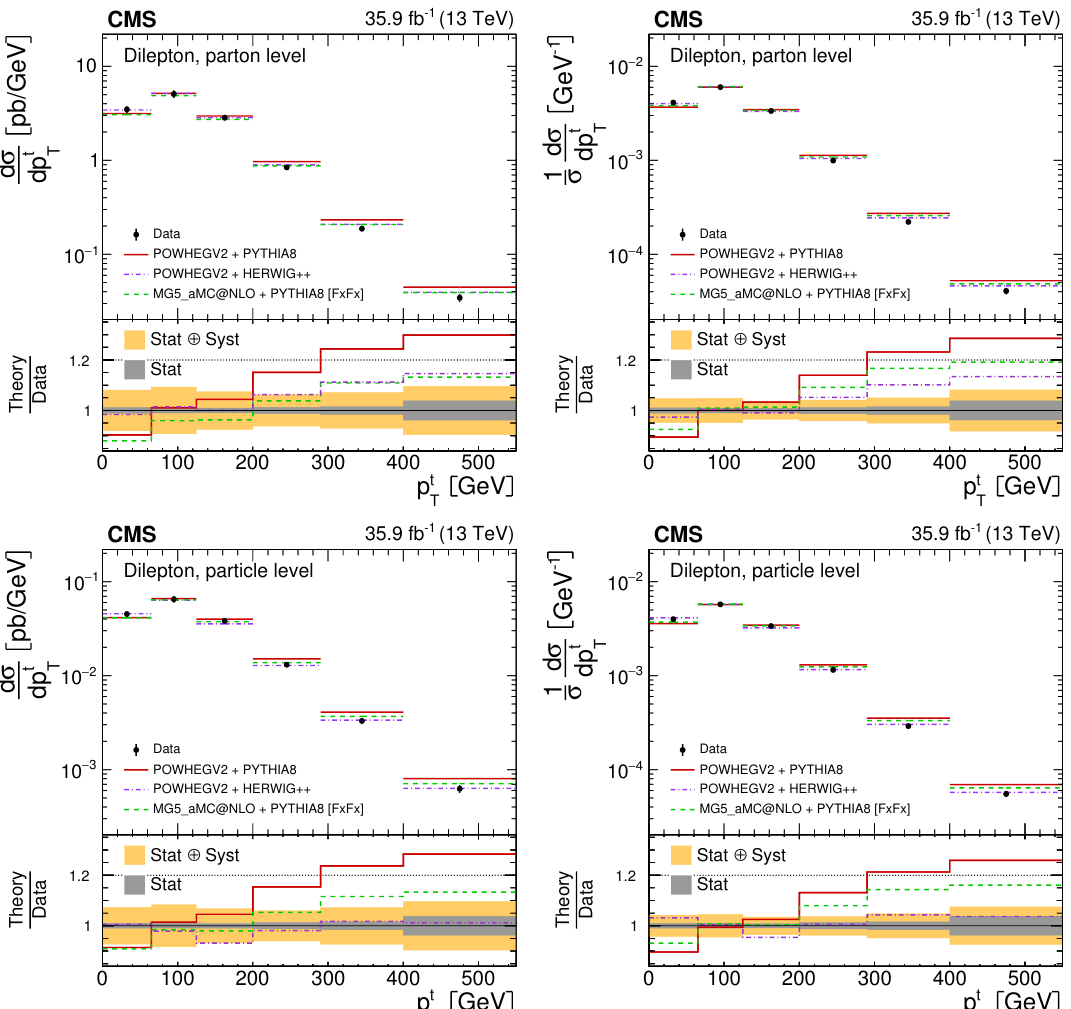
Figure 3 . The di(cid:11)erential tt production cross sections as a function of p t data (points) and the MC predictions (lines). The vertical lines on the points indicate the total uncertainty in the data. The left and right columns correspond to absolute and normalised mea- surements, respectively. The upper row corresponds to measurements at the parton level in the full phase space and the lower row to the particle level in a (cid:12)ducial phase space. The lower panel in each plot shows the ratios of the theoretical predictions to the data. The dark and light bands show the relative statistical and total uncertainties in the data,